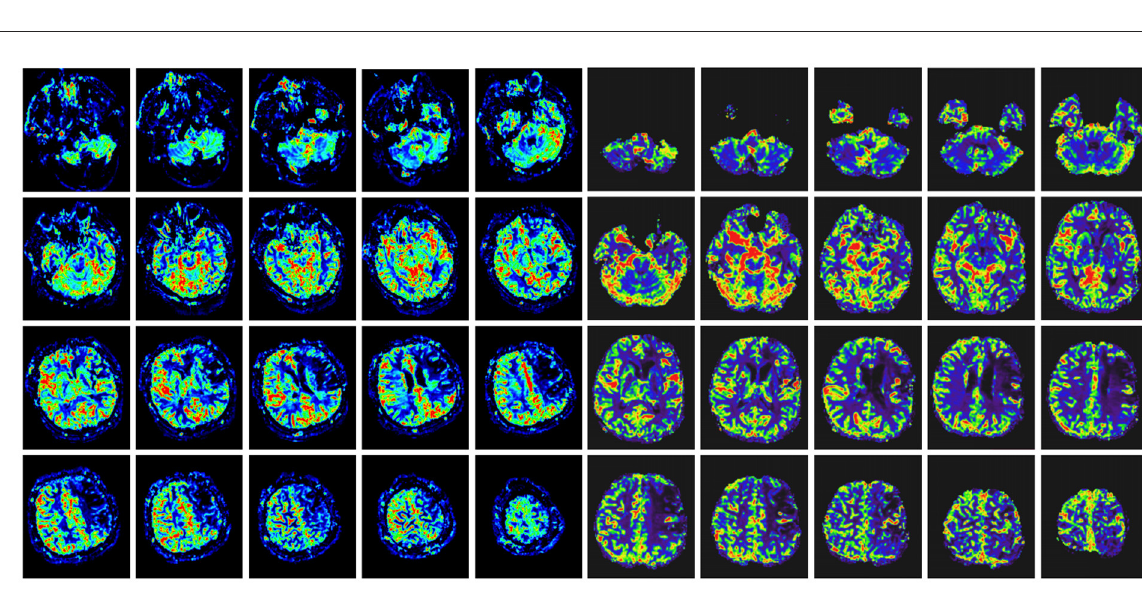
was 3.0 ± 0.25, and the mean 1 STA-MTT was 2.75 ±